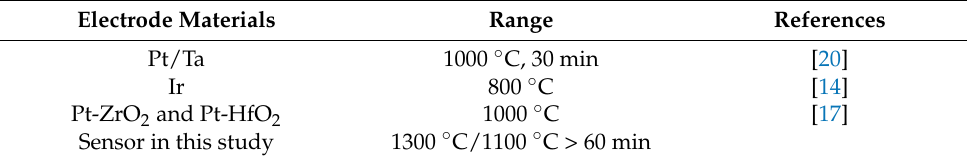
Table 1. Comparison between the sensors we studied and previously reported